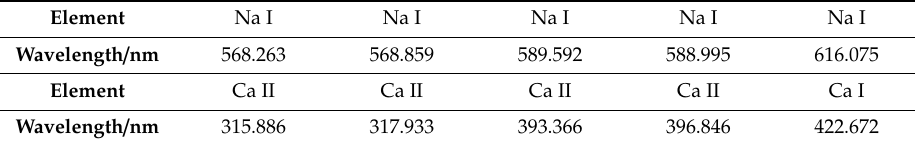
Table 2. Wavelength of typical spectral lines for sample by